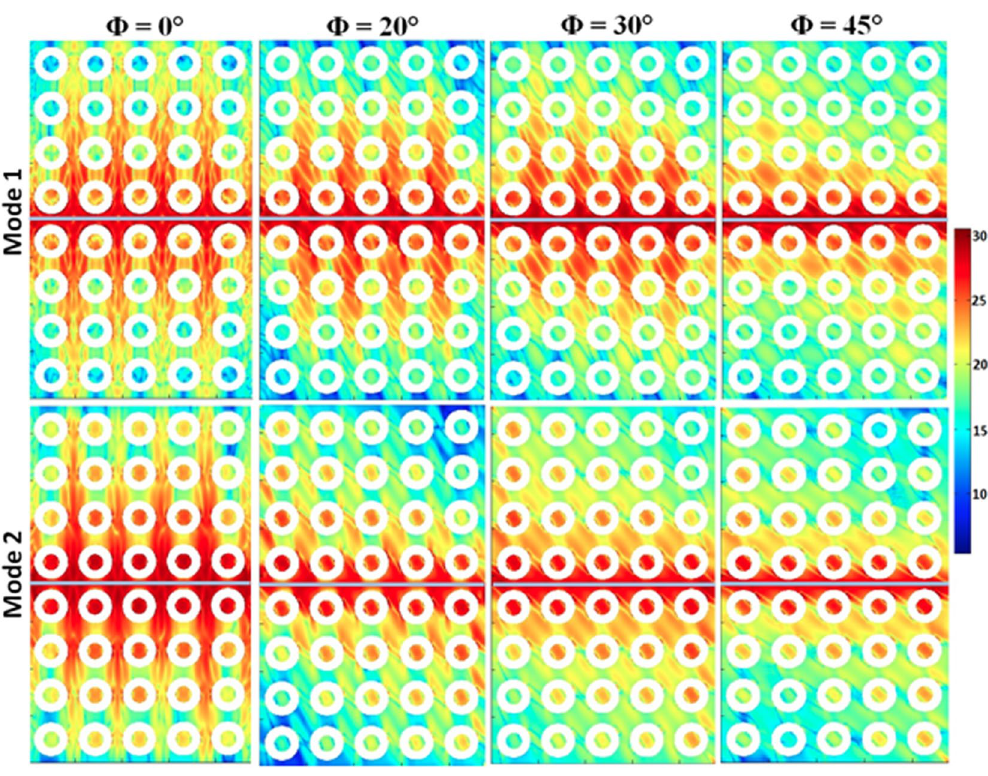
Figure 5. Simulated power profiles of spin-wave mode 1 and mode 2 excited locally over the rectangular strip place at middle of the sample for φ = 0°, φ = 20°, φ = 30°, and φ = 45° geometries.